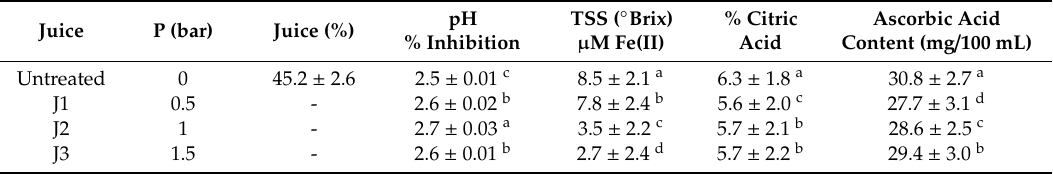
Table 1. E ff ect of di ff erent pressure on juice physicochemical Table 1. Effect of different pressure on juice physicochemical parameters.